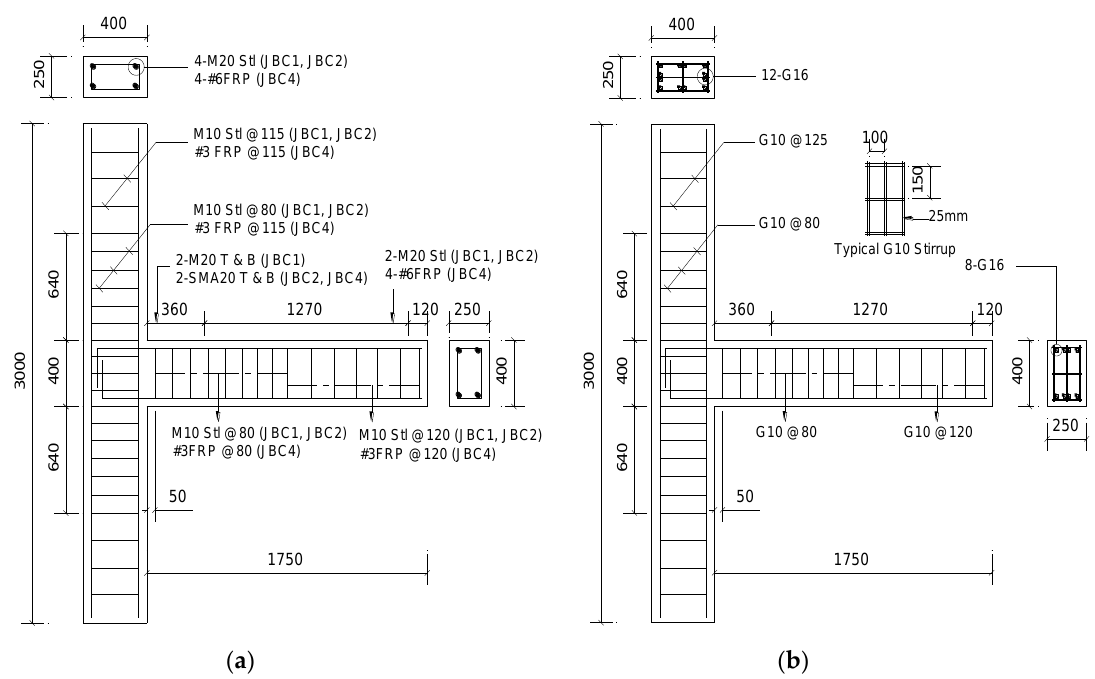
Figure 1. Reinforcement details of specimens (all dimensions in mm) ( a ) JBC1, JBC4 (adapted from [36]) & JBC2 (adapted from [37]) ( b ) J4 (adapted from [7]).